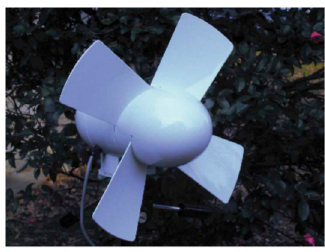
Figure 8. Very small wind turbine designed by Hirahara et al. [111].